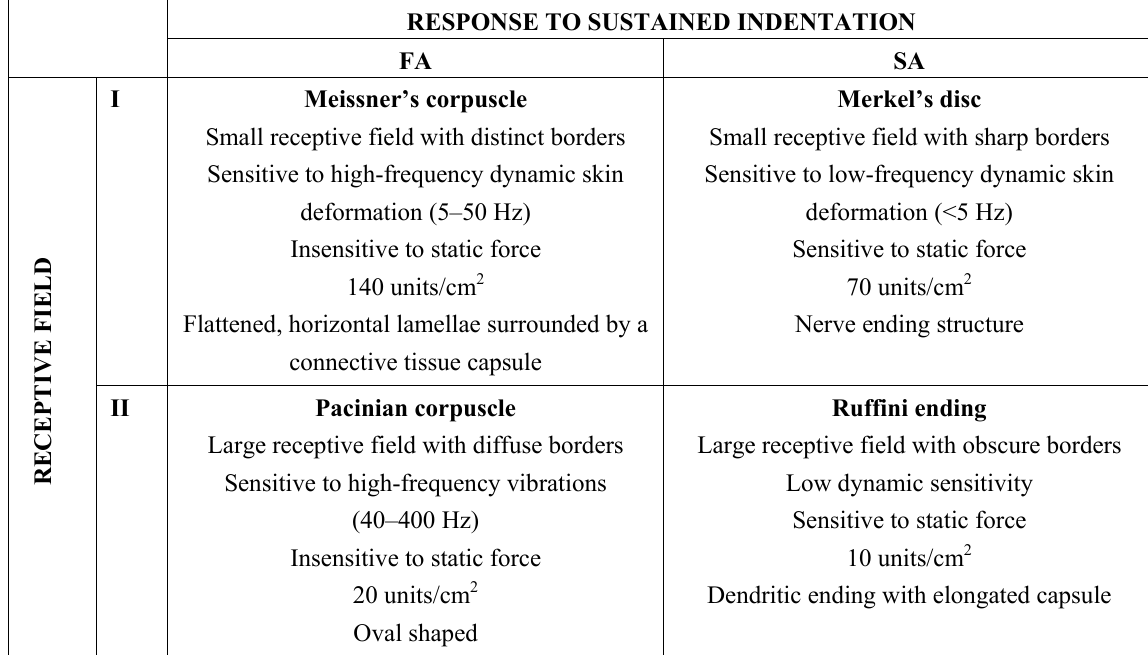
Table 1. Types of tactile units in the glabrous skin of the human hand, their density, and functional and morphological properties (synthesis from [20] and